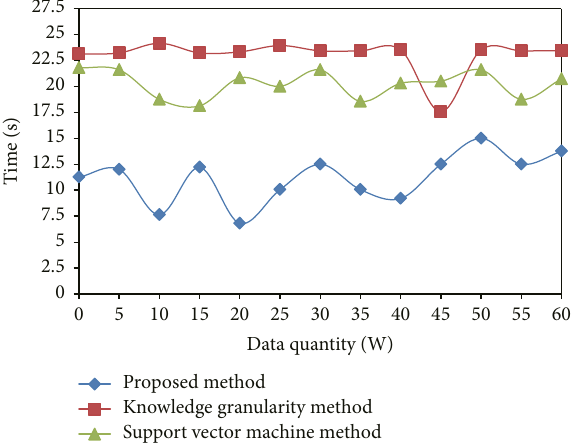
Figure 14: Comparison of outlier data mining efficiency.